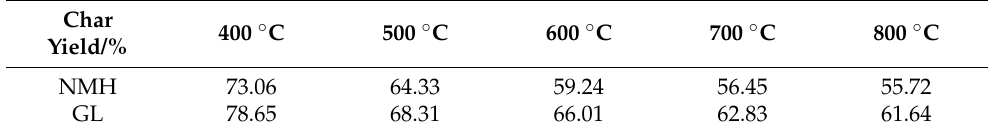
Table 6. Char yields of NMH and GL raw coal in pyrolysis.